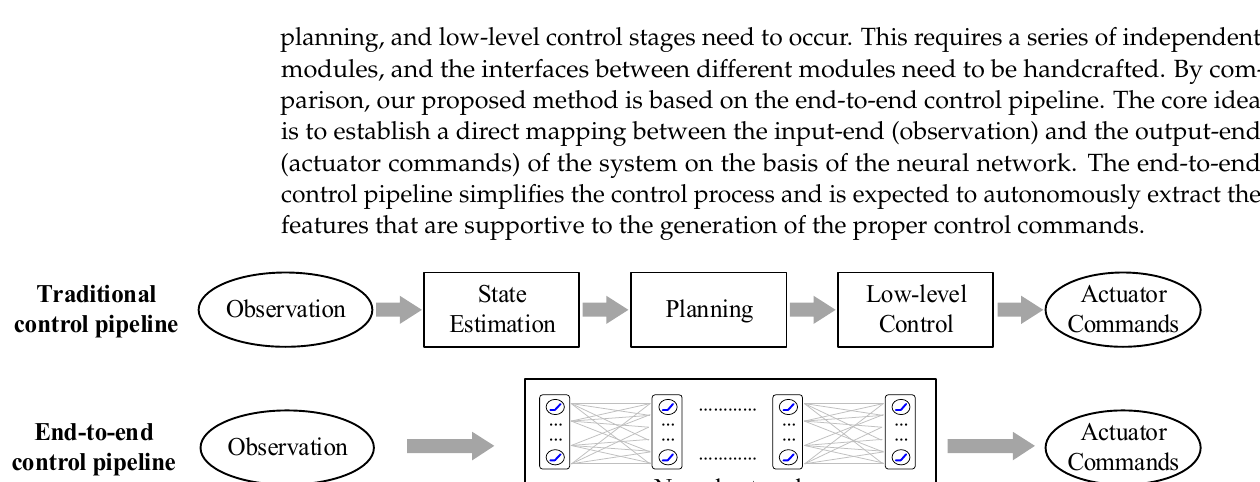
Figure 2. Comparison of the traditional control and end-to-end control pipelines.